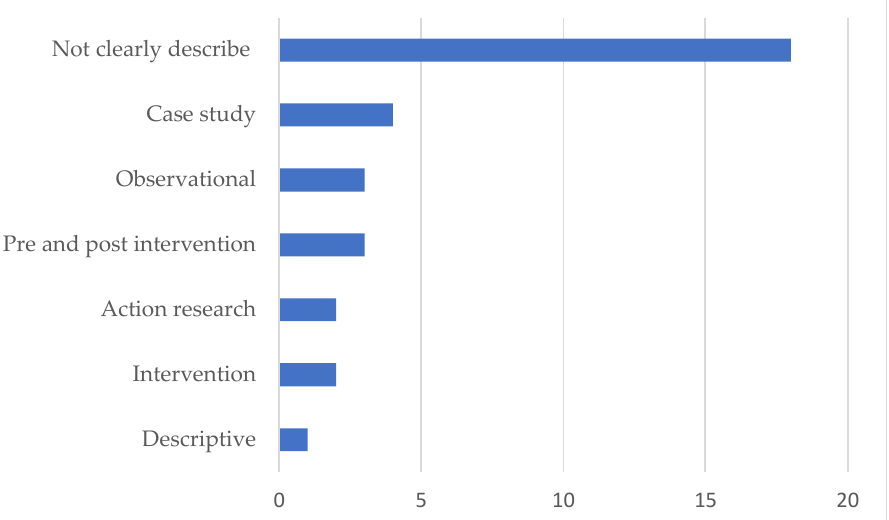
Figure 5. Study designs adopted by researchers.